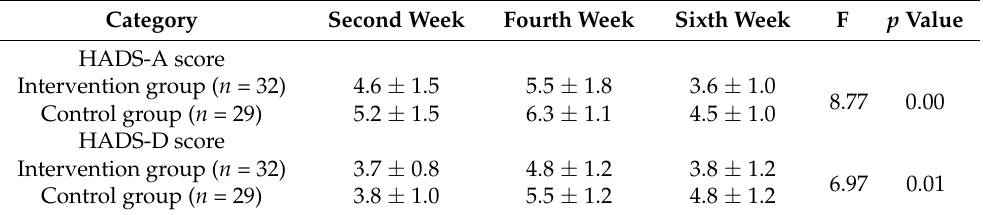
Table 5. Comparison of HADS-A and HADS-D between the two groups (Mean ± SD); Abbrevia- tions: HADS-A, Hospital Anxiety and Depression Scale- Anxiety; HADS-D, Hospital Anxiety and Depression Scale- Depression.